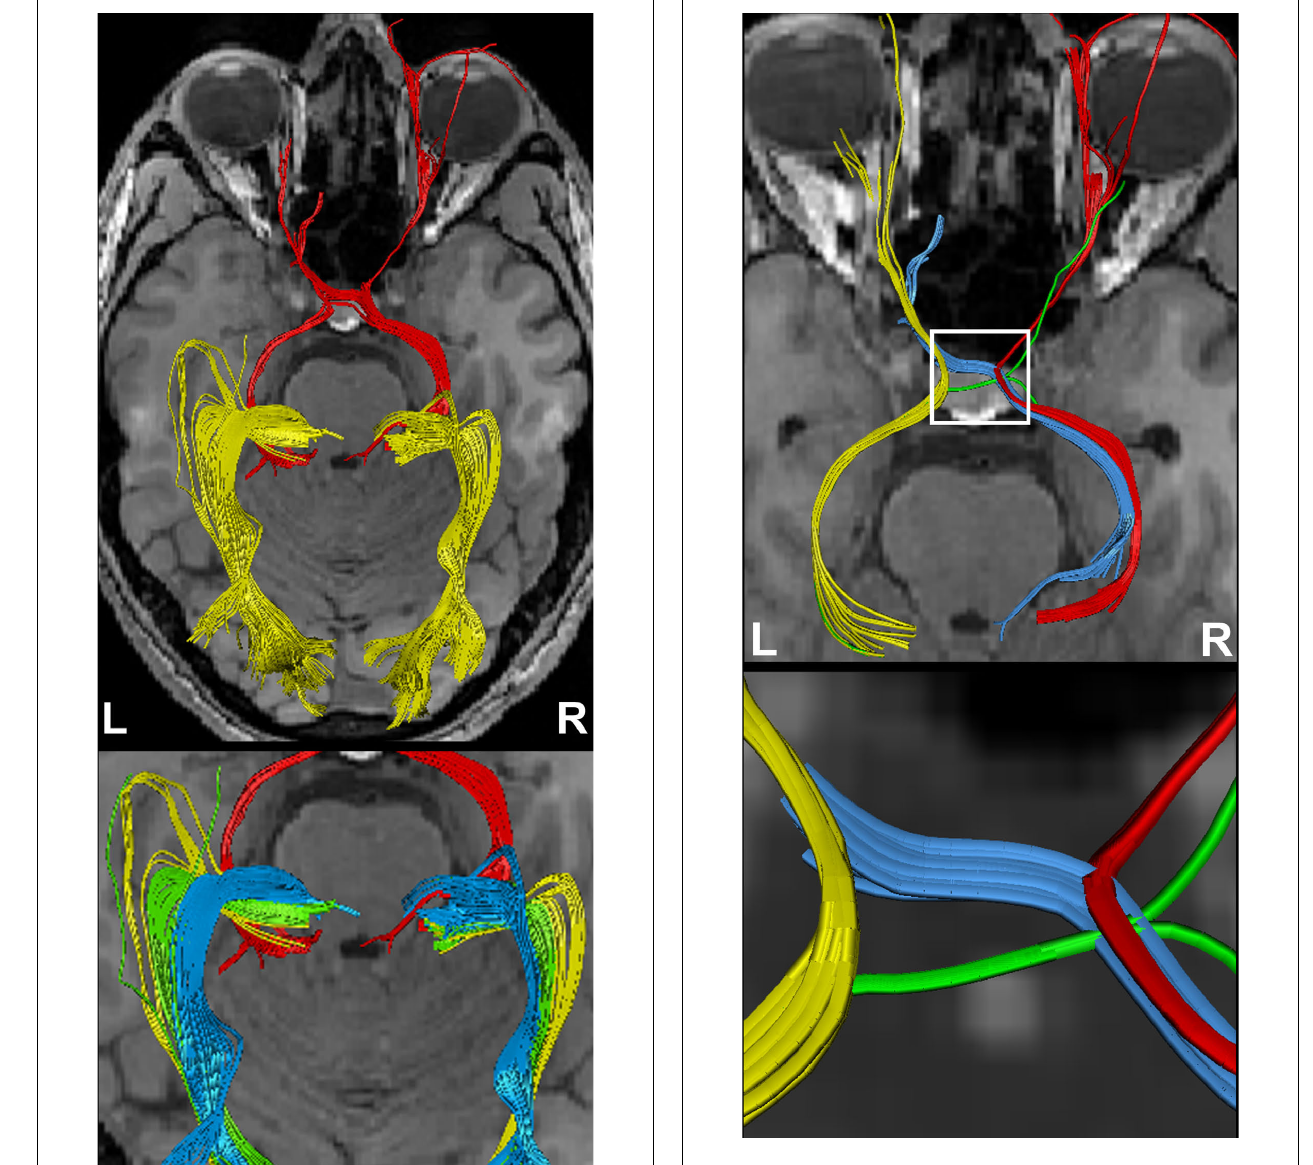
FIGURE 5 | (Top) Separation of right- and left-hemispheric fi bers in the optic nerve and optic tract. (Bottom) Magnifi cation of fi ber tracks crossing the optic chiasm: tracks from the left eye to the left (yellow) and right LGN (blue), tracks from the right eye to the left (green) and right LGN (red). R, right, L,